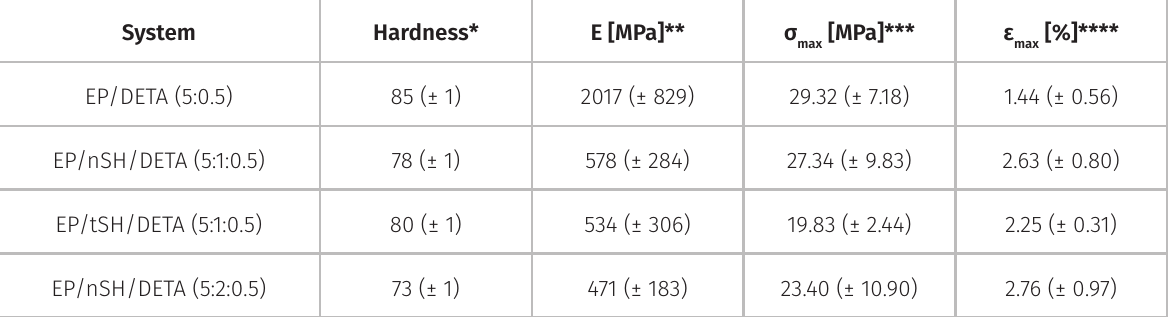
Table VI. Shore D harness and tensile properties of epoxy-mercaptan-amine systems obtained from different samples and compositions, all reacted at 25 o C.